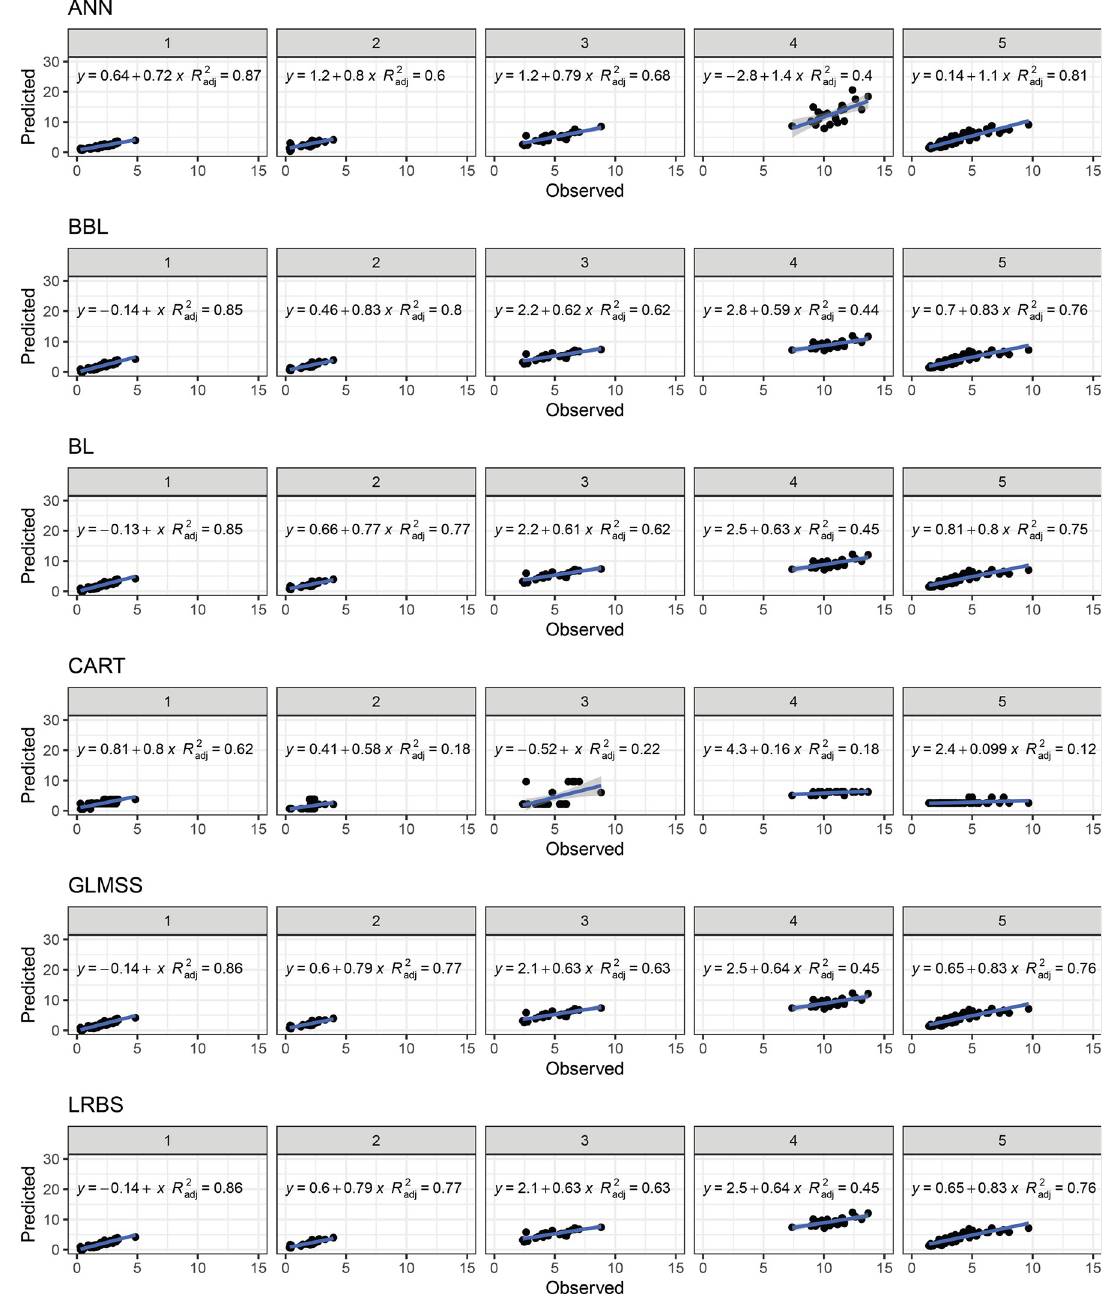
Fig 8. Relationship between observed and predicted values for total carotenoid content of cassava roots. The prediction was performed based on 12 different models based on PCA clustering-based with k = 5 (IV-Cluster). Artificial Neural Network (ANN), Bayesian Blasso (BBL), Bayesian Lasso (BL), Classification and Regression Trees (CART), Generalized Linear Model with Stepwise Feature Selection (GLMSS), and Linear Regression with Backward Selection (LRBS). The numerical data included in the graphs represent: linear equations (y) and coefficient of determination (R 2